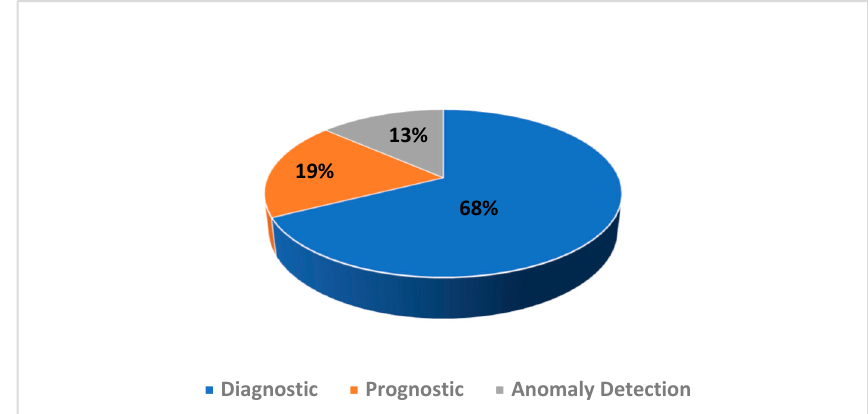
Figure 3. Distribution of PHM tasks for the selected articles.